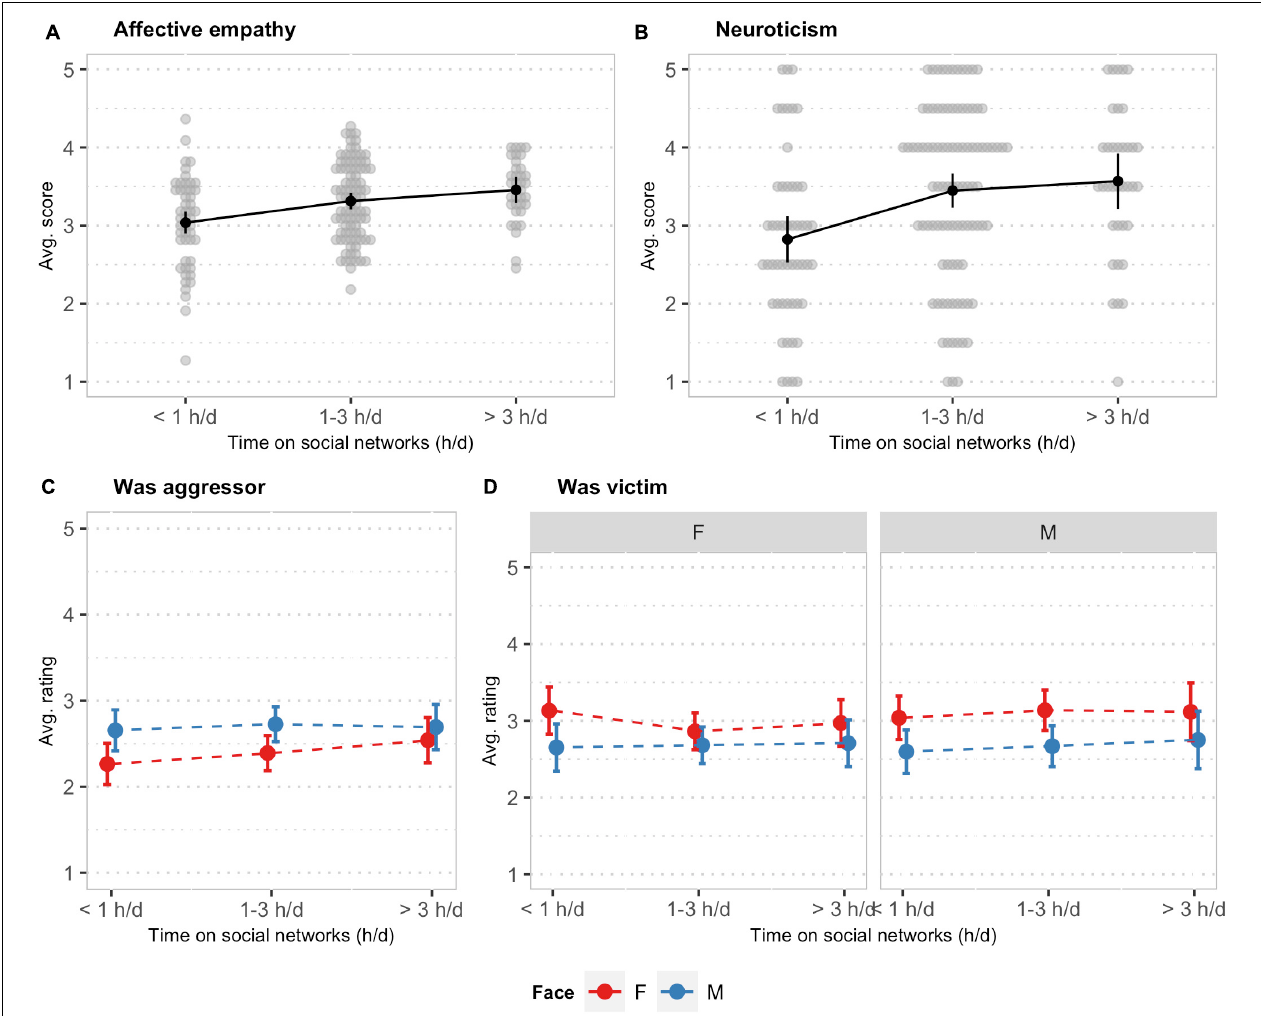
FIGURE 6 | Plot of the marginal means of (A) affective empathy, (B) neuroticism, (C) ratings of a past of aggressor, and (D) ratings of a past as a victim, as a function of time spent on social media (A–D) and (C) face gender or (D) face and observer gender. In (A) , a continuous variable, and (B) , a discrete variable, the gray circles are individual data points. Error bars are 95% confidence intervals for the